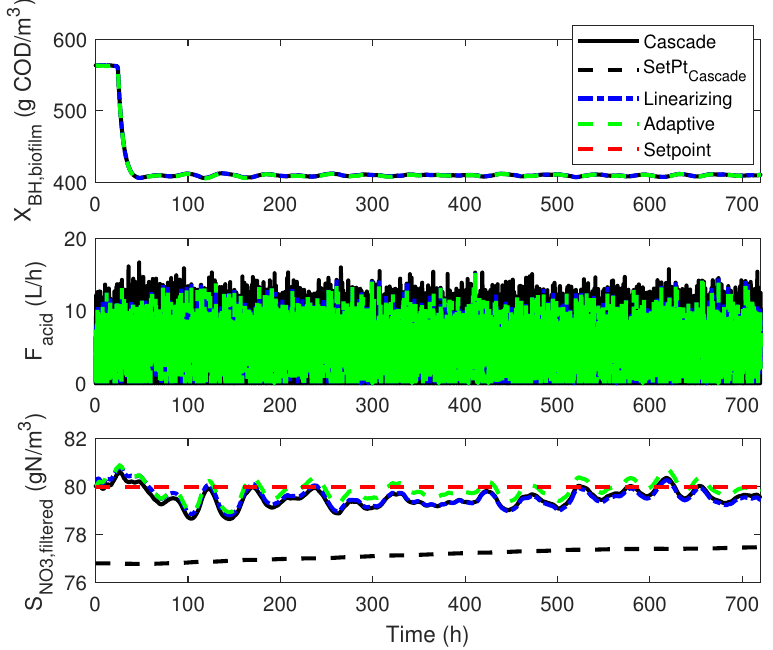
Figure 18. Simulation results obtained for the linearizing, adaptive and cascade controllers when the biomass death rate is increased and a 10% measurement noise on all measured variables ( S NO 3 , S S , S O and X BH ) is added and when a higher steady-state nitrate concentration and setpoint are considered. SetPt Cascade represents the corrected setpoint curve and Setpoint is the desired